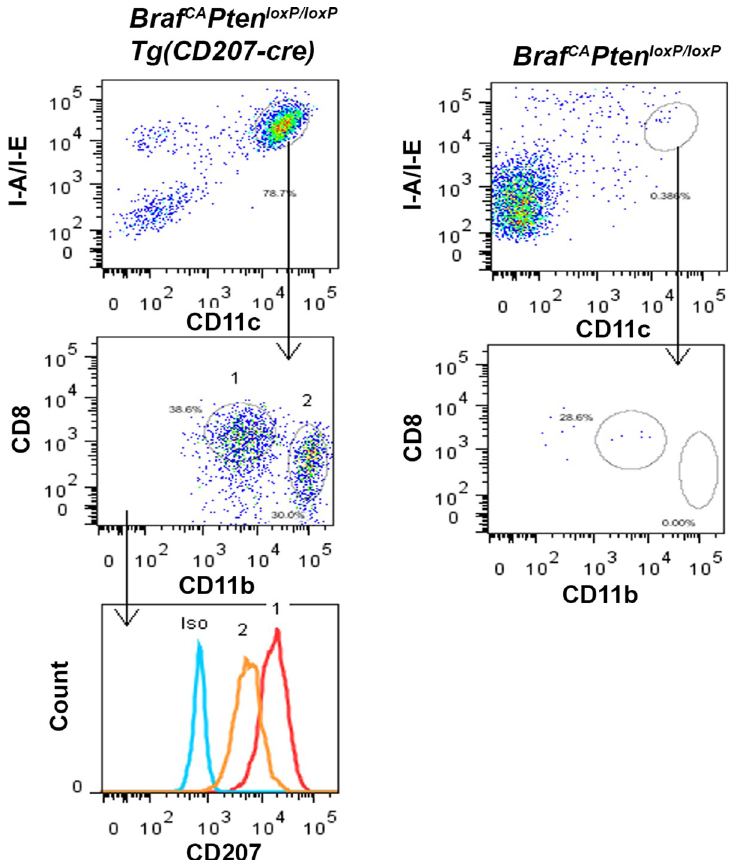
Braf CA Pten loxP/loxP Tg(CD207-cre) and Braf CA Pten loxP/loxP mice were sorted for I-A/I-E and CD11c expression. Abundant double positive cells were present in the thymus of Braf CA Pten loxP/loxP Tg(CD207-cre) but not Braf